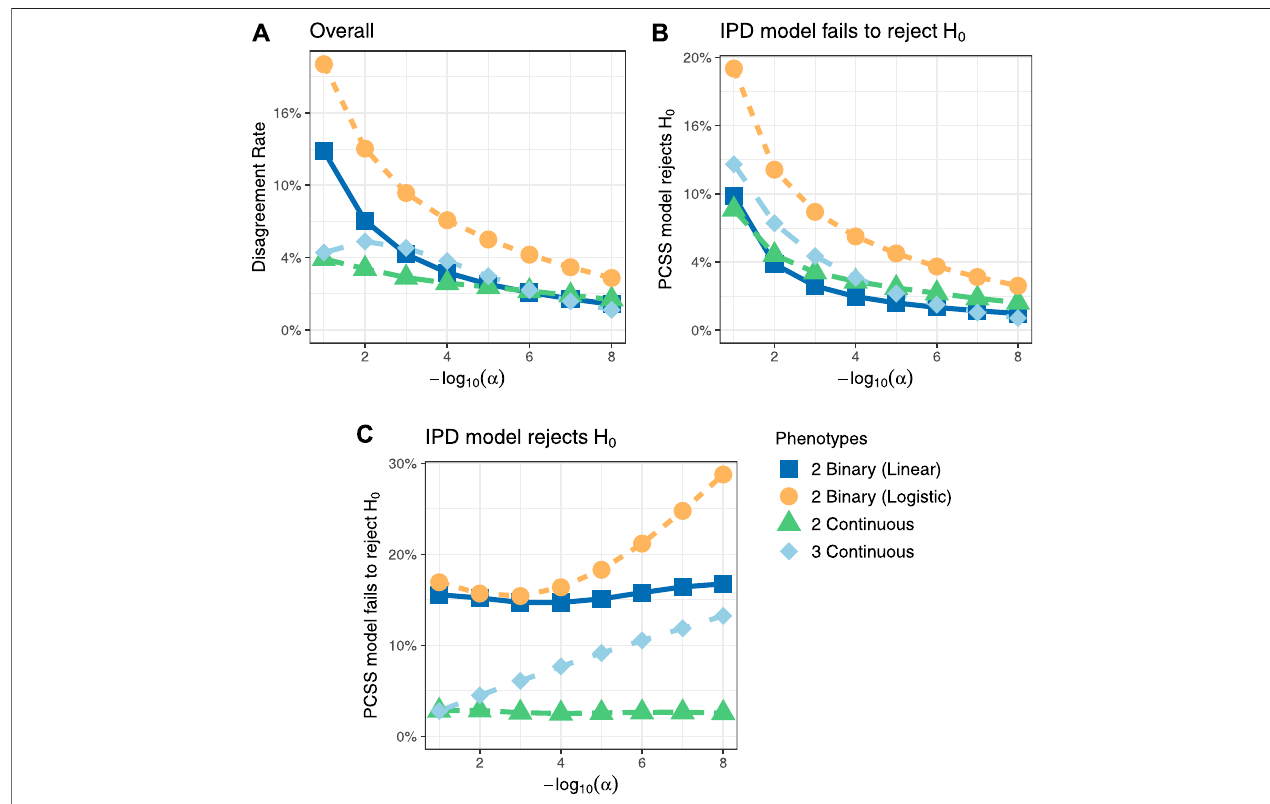
FIGURE 4 | Simulation studies ’ test decision disagreement rates evaluating the signi fi cance of a SNP in a linear model for a product of phenotypes while adjusting for covariates using individualized participant data (IPD) and pre-computed summary statistics (PCSS) at various signi fi cance thresholds ( α ). Comparisons were also made between a logistic regression model fi t using IPD on the product of two binary phenotypes and the PCSS model approximating the linear relationship. (A) Percentage of times the PCSS and IPD models ’ test decisions disagreed across all simulations. (B) Percentage of times the PCSS model rejected the null hypothesis given that the IPD model failed to reject the null hypothesis. (C) Percentage of times the PCSS model failed to reject the null hypothesis given that the IPD model rejected the null hypothesis.